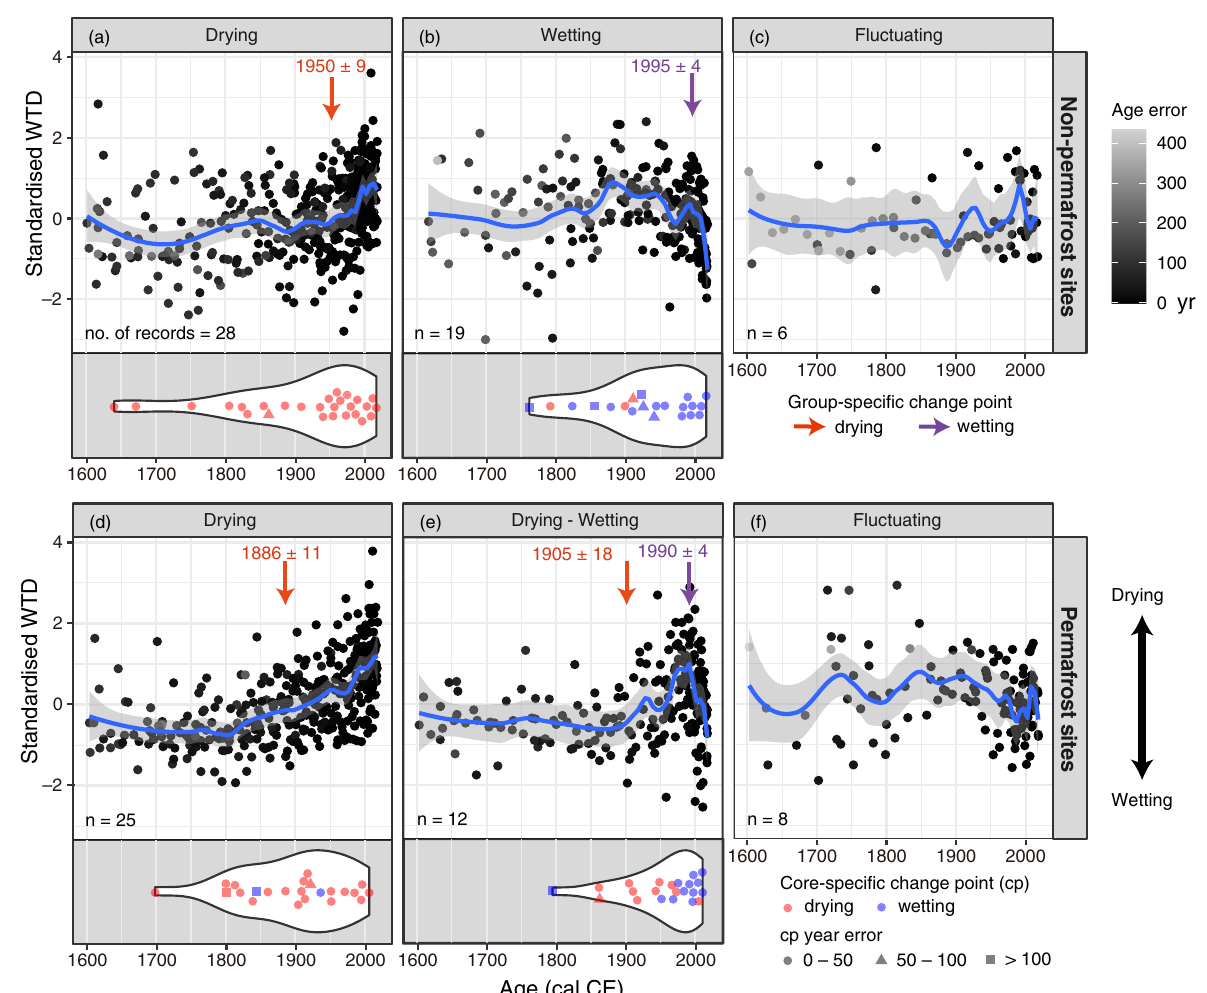
Fig. 2 | Standardised water-table depth (WTD) data over the past centuries compiled into different hydrological response groups. Non-permafrost ( a – c ) and permafrost ( d – f ) sites are plotted separately. A LOESS model is shown as a blueline, withthe grayshadingindicatingthe95% con fi denceinterval.Theage error scale indicates the chronological precision of each data point (deter- mined through Bayesian age modelling). Inside-plot arrows indicate the